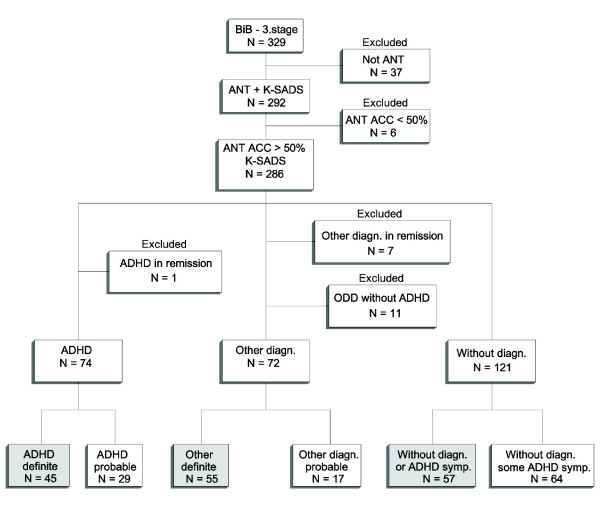
Flow chart visualizing the selection procedure.